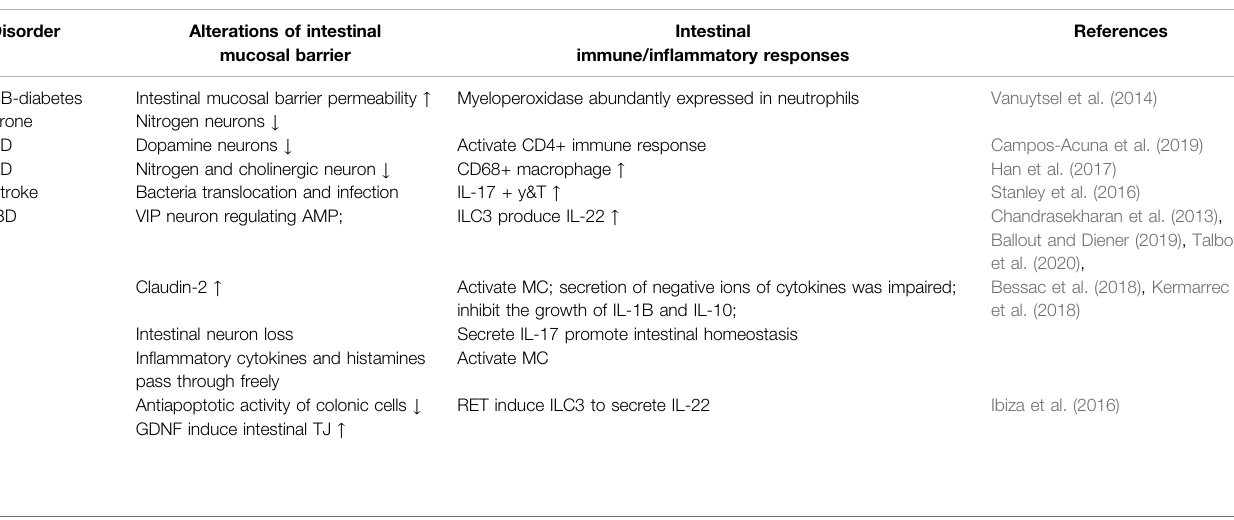
TABLE 4 | Summary of ENS-intestinal immunity manifestations in different diseases. Disorder Alterations of intestinal mucosal